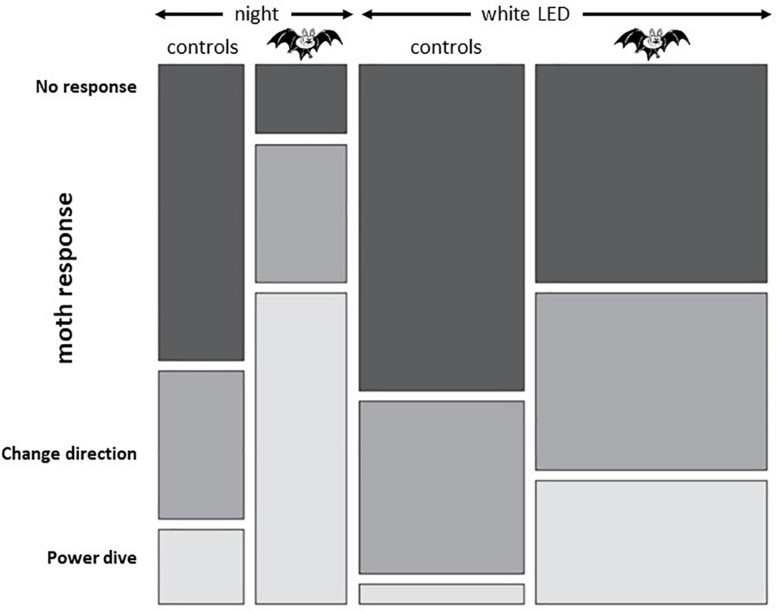
The mosaic plot illustrates the proportion of moth flight responses under four different conditions: absence or presence of bats (Nyctalus sp.) under total darkness or white LED illumination, in the area of Bristol (United Kingdom). Moths respond to the presence of bats under unlit conditions at night by escape movements. This escape behaviour is markedly affected in the presence of white LED. Column width is proportional to sample size. From Wakefield et al. (2015). No special permission required.